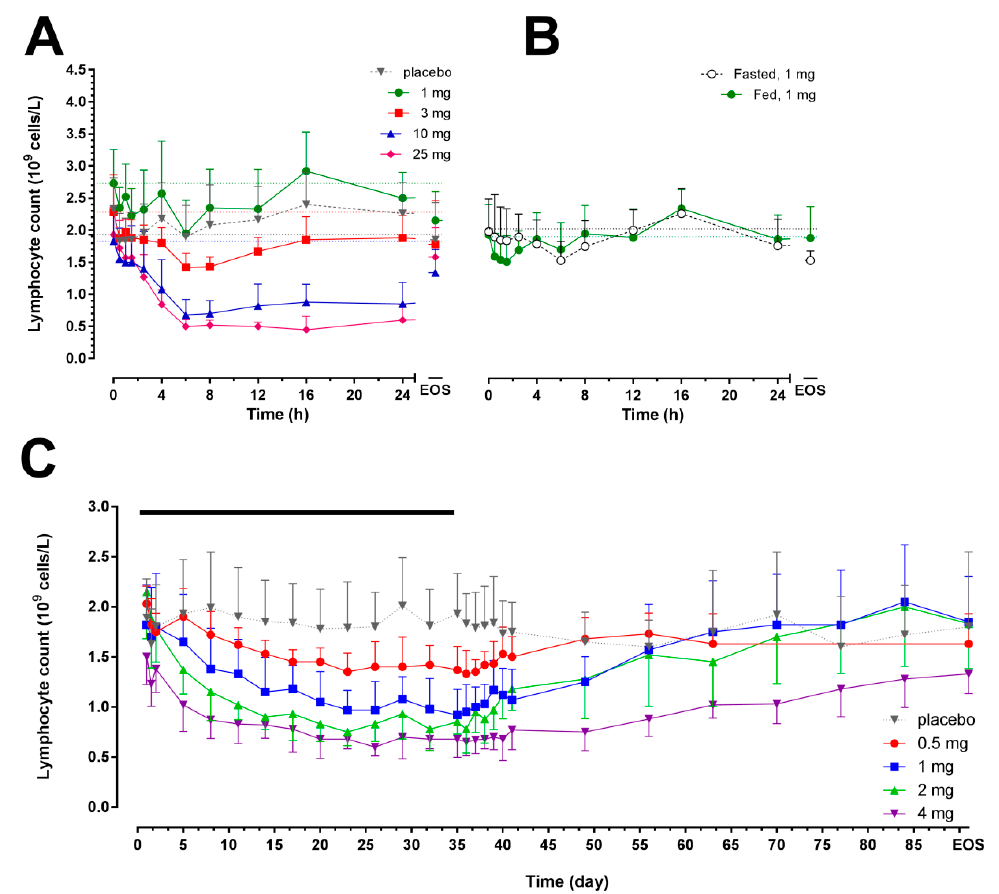
Figure 2. Arithmetic mean (with standard deviation) lymphocyte count in peripheral blood versus time profiles from 0 h to EOS after single-dose administration of cenerimod (Panel ( A ), N = 6 per dose group, N = 8 for placebo group); single-dose administration in fed or fasted conditions (Panel ( B ), N = 8); and after multiple o.d. oral doses for 35 days (Panel ( C ), N = 6 per dose group, N = 8 for placebo group). The black bar represents the treatment duration. The horizontal dotted lines represent the baseline values. EOS: end-of-study.